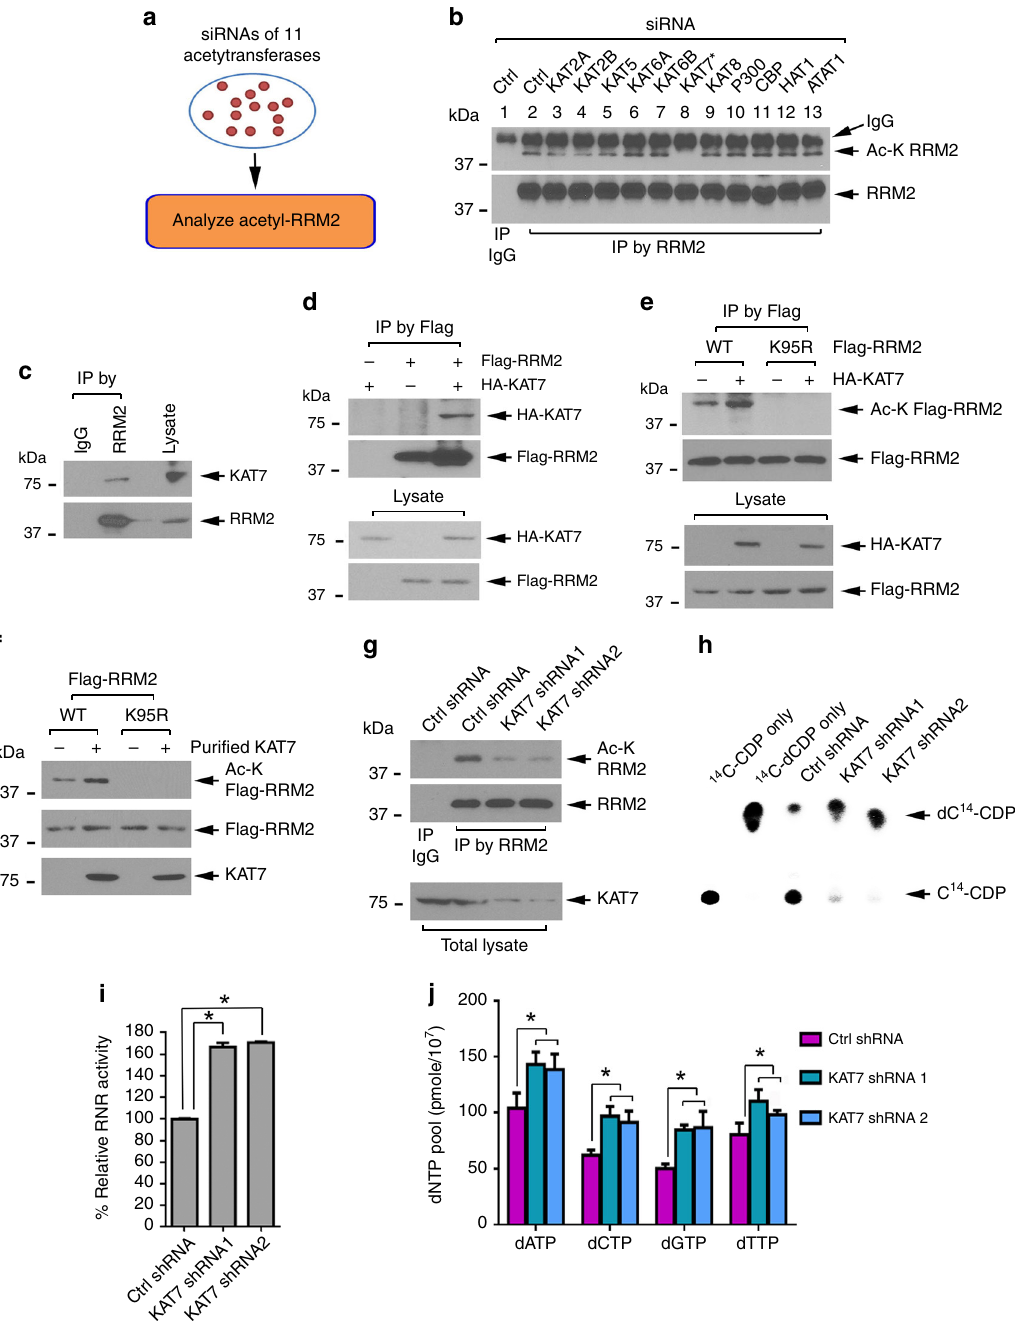
Fig. 3 KAT7 functions as a physiological RRM2 acetyltransferase. a siRNA screening strategy to identify RRM2 acetyltransferases. b H1299 cells were transfected with a library of 11 known protein acetyltransferase siRNAs, followed by IP with RRM2 antibody, and western blot using Ac-K antibody. c A co-IP was performed in H1299 cells with RRM2 antibody to measure endogenous KAT7/RRM2 interaction. d H1299 cells were co-transfected with Flag-RRM2 and HA-KAT7 constructs, followed by a co-IP to detect exogenous Flag-RRM2/HA-KAT7 interaction. e Co-transfection of Flag-tagged WT or K95R mutant RRM2 with HA-KAT7 constructs into H1299 cells, followed by IP using Flag, and western blot using anti-Ac-K antibody. f Puri fi ed Flag-RRM2 WT or K95R mutant protein were incubated with recombinant KAT7 protein, followed by analysis of RRM2 acetylation as above. g Endogenous KAT7 in H1299 cells was depleted by KAT7 shRNA, followed by analysis of RRM2 acetylation. h , i Endogenous KAT7 in H1299 cells was depleted by KAT7 shRNA, followed by analysis of RNR activity. The error bars indicate±s.d. of three separate experiments. * P <0.05, by two-tailed t test. j Intracellular dNTP levels were measured in H1299 cells expressing KAT7 shRNA1, KAT7 shRNA2, and Ctrl shRNA. The error bars indicate±s.d. of three separate experiments. * P <0.05, by two-tailed t